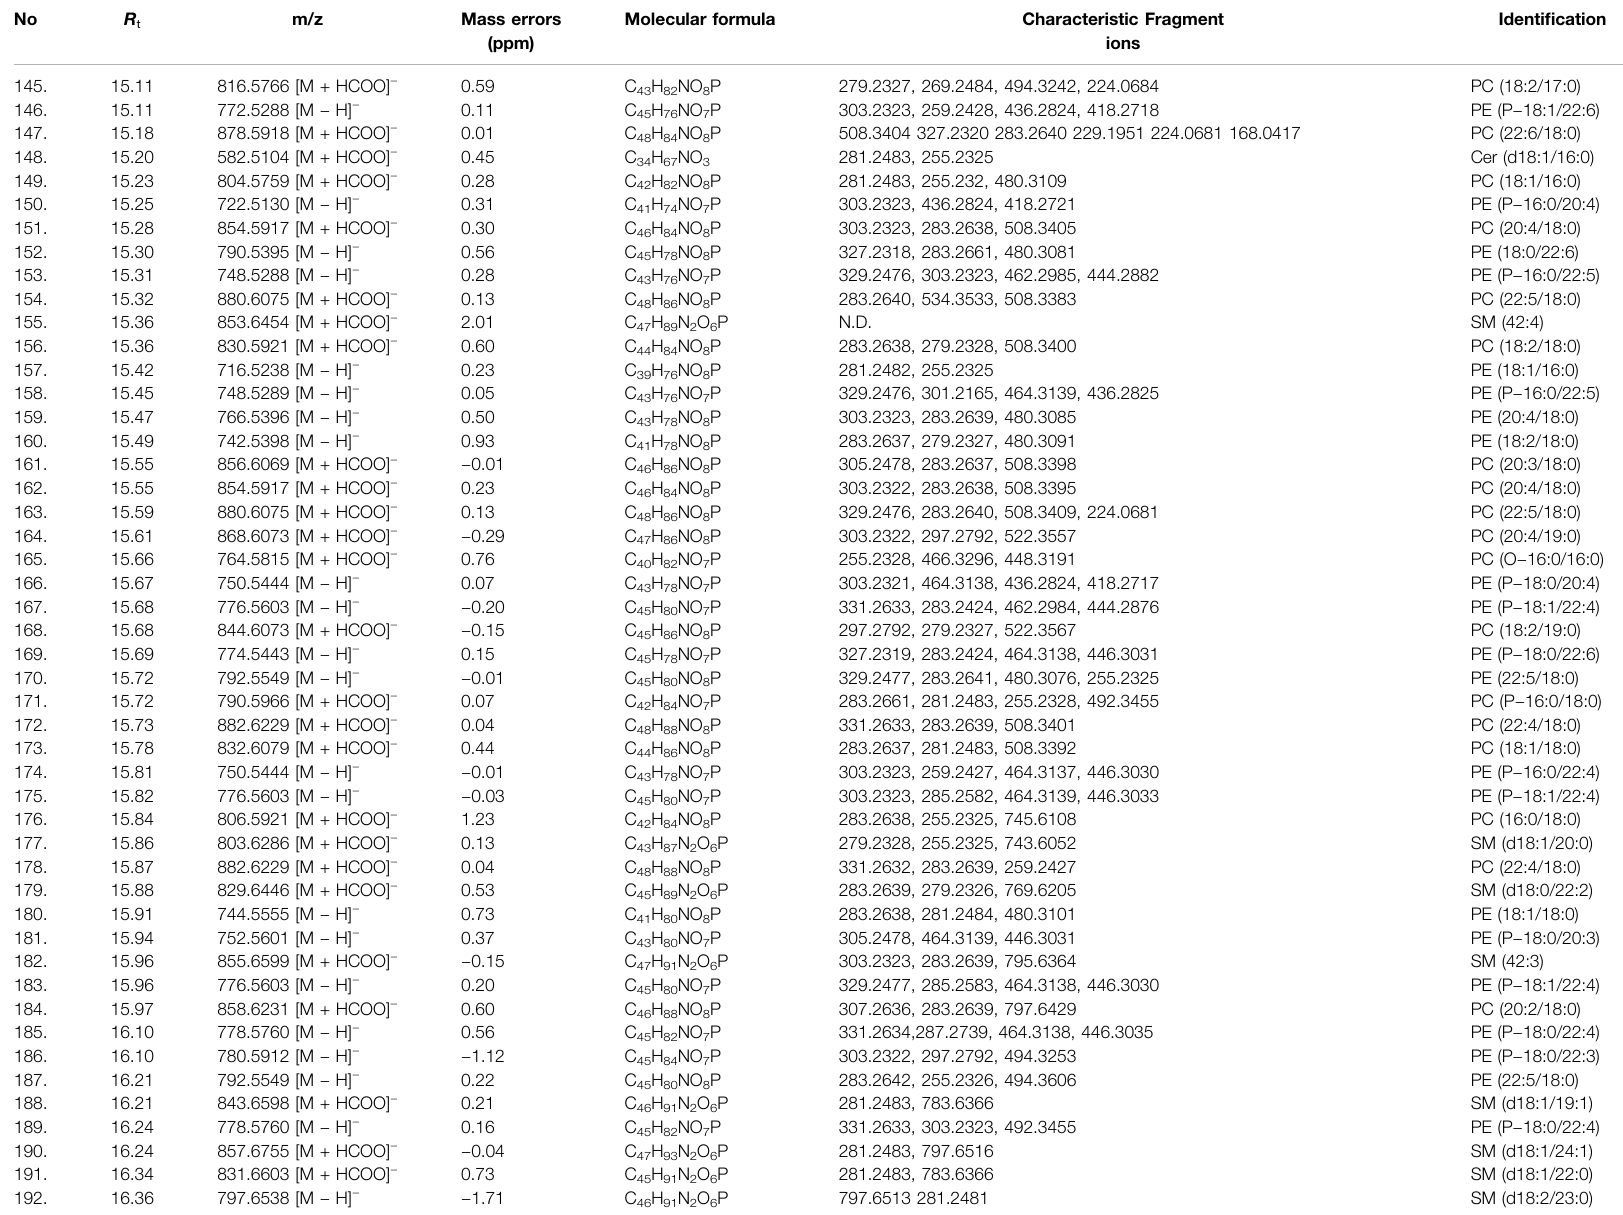
TABLE 2 | ( Continued ) The detected and tentatively identi fi ed lipid molecules in the rat liver. No R t m/z Mass errors